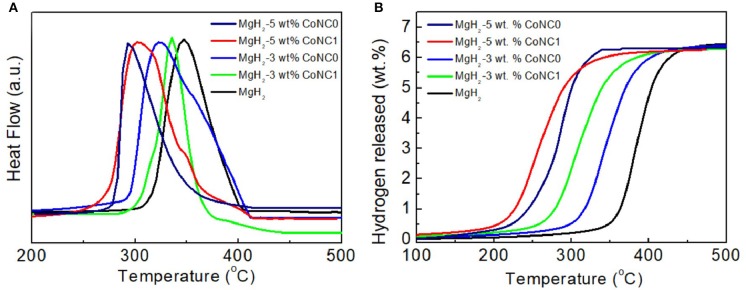
The TPD plots (A) and the corresponding H2 desorption amount curves (B) of the pure MgH2 and MgH2-CoNC composites.